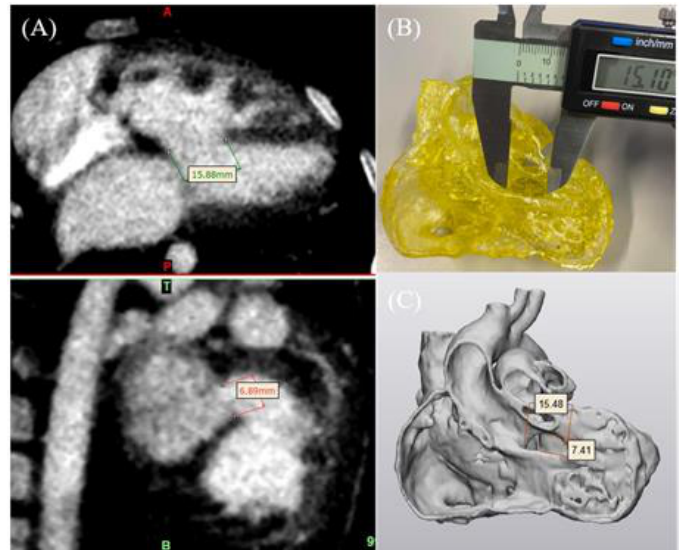
Figure 4. 3D-printed model accuracy. ( A ) CT imaging data in coronal and sagittal views (left top and bottom images) to measure the VSD on source imaging data. ( B ) Measurement of the VSD in the 3D-printed model using a digital calliper. ( C ) STL file measurement of the VSD in 3-Matic. VSD—ventricular septal defect. Reprinted with permission under the open access from Lee et al. [22]. Table 2. 3D-printed heart model accuracy in comparison with original source images according to the current literature. Modified from Lee et al.